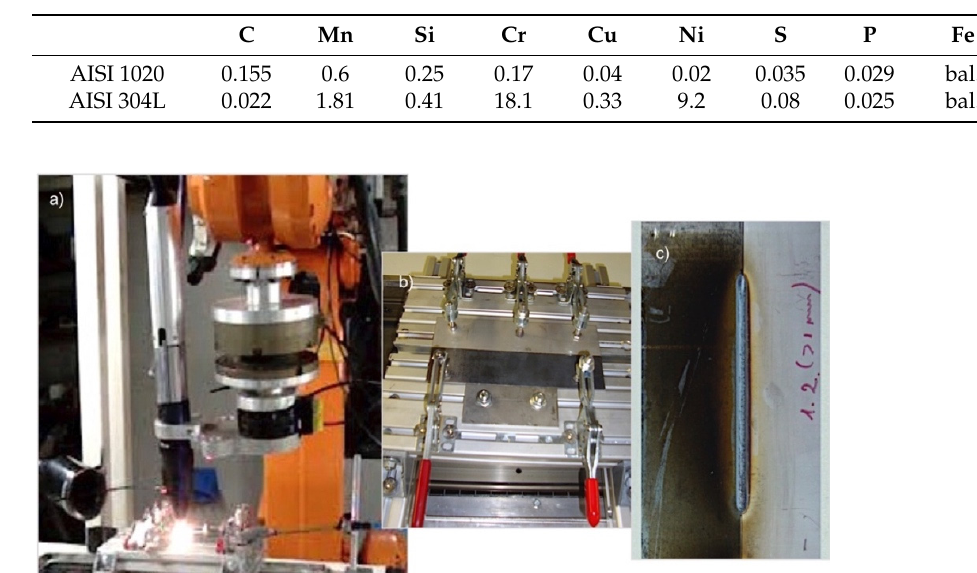
Figure 1. System setup. ( a ) General view acquired during autogenous laser welding; ( b ) clamping device used for the plates fixing; ( c ) dissimilar but welded joint. Table 1. Base metals chemical composition (wt%). Table 2. Autogenous laser welding parameters.